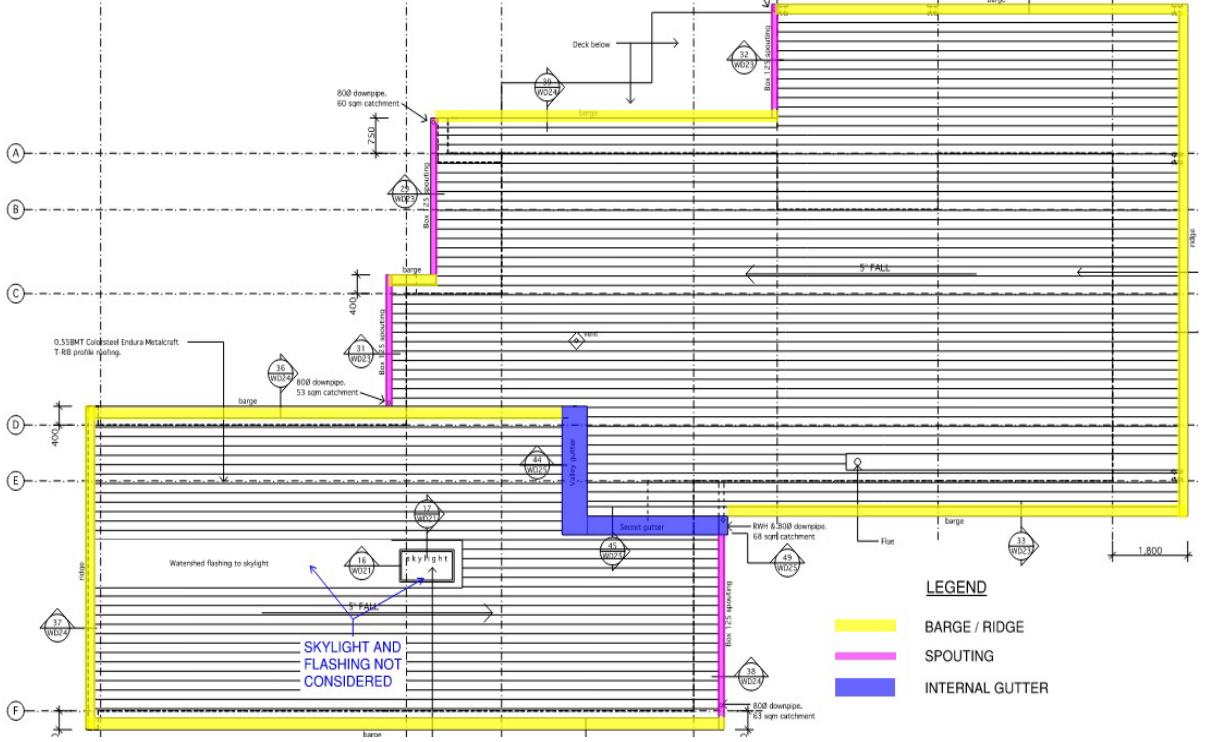
Figure 2. Roof level plan of the case study house (all measurements are in millimetres and scaled 1:100). Table 1. Bill of materials for case study house.